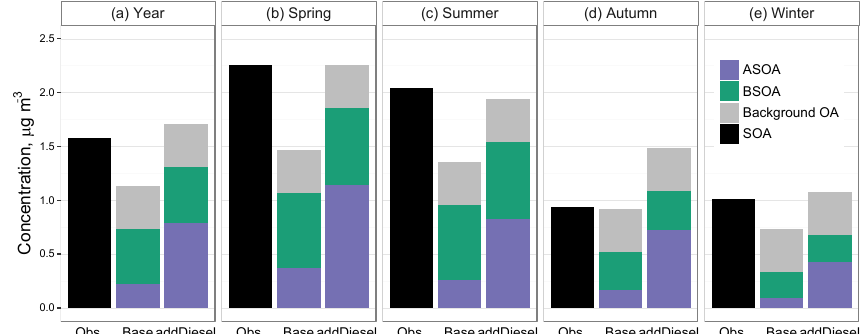
Figure 17. Annually and seasonally averaged measured and modelled concentrations of SOA at the London North Kensington site.